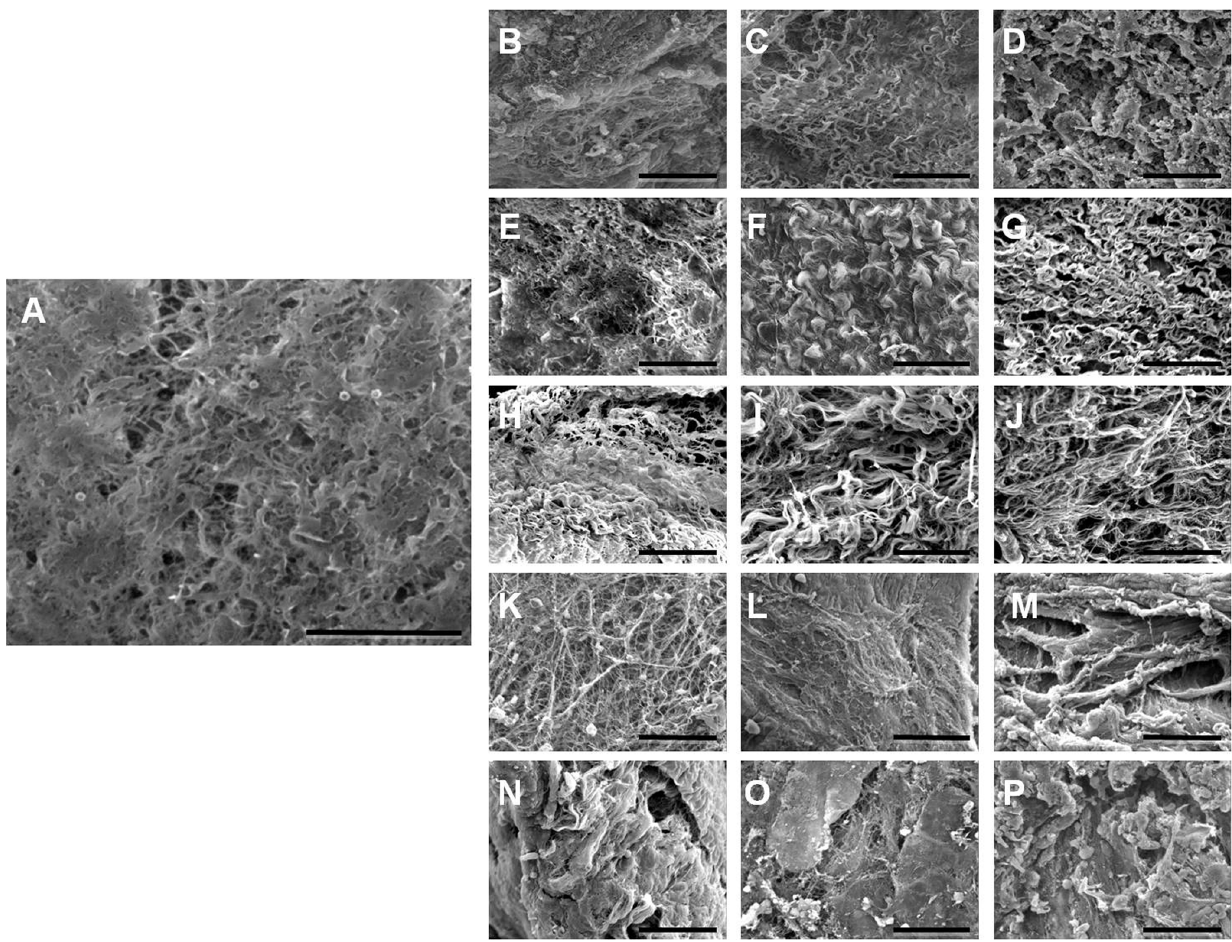
Figure 2. Scanning electron microscopy (SEM) images of control SI samples (A), and tissues decellularized with 1.5 M NaCl (B), 3 M NaCl (C), 5 M NaCl (D), 0.1% SDS (E), 0.3% SDS (F), 0.6% SDS (G), 0.1% triton X-100 (H), 0.3% triton X-100 (I), 0.6% triton X-100 (J), 10 min SC (K), 20 min SC (L), 30 min SC (M), 10 min UV (N), 20 min UV (O) and 30 min UV (P). Scale bar represents 50 m m.